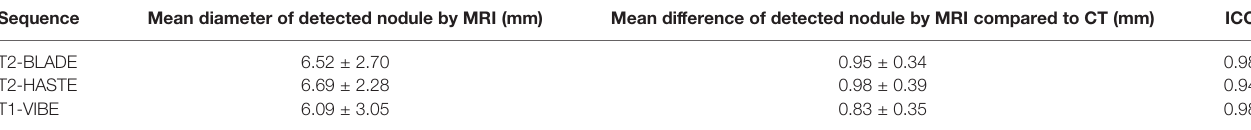
TABLE 4 | Mean diameter and mean difference of detected nodules for each sequence and correlation of MRI measurements compared to CT. Sequence Mean diameter of detected nodule by MRI (mm) Mean difference of detected nodule by MRI compared to CT (mm)